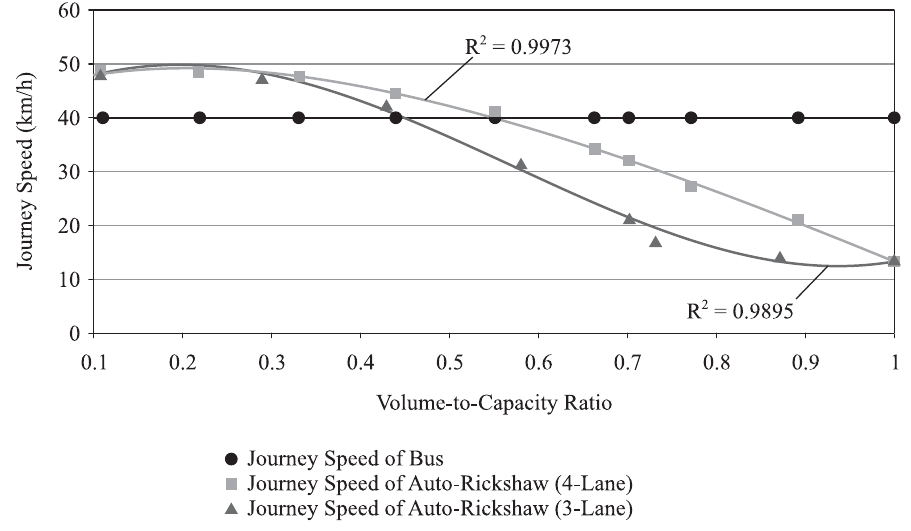
Fig. 2. Journey speed of buses and